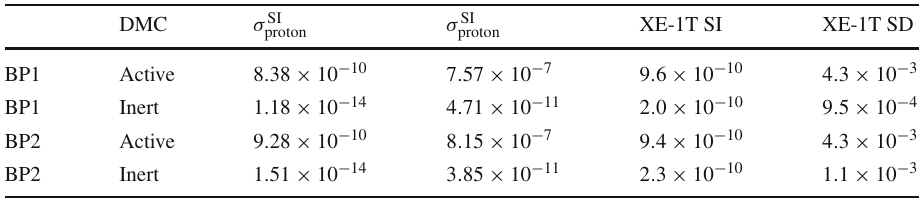
Table 3 Direct detection cross sections (in pb) for the two DM Candidates (DMCs) and the corresponding limits from XENON-1T for the spin-independent [47] and spin-dependent [48] case